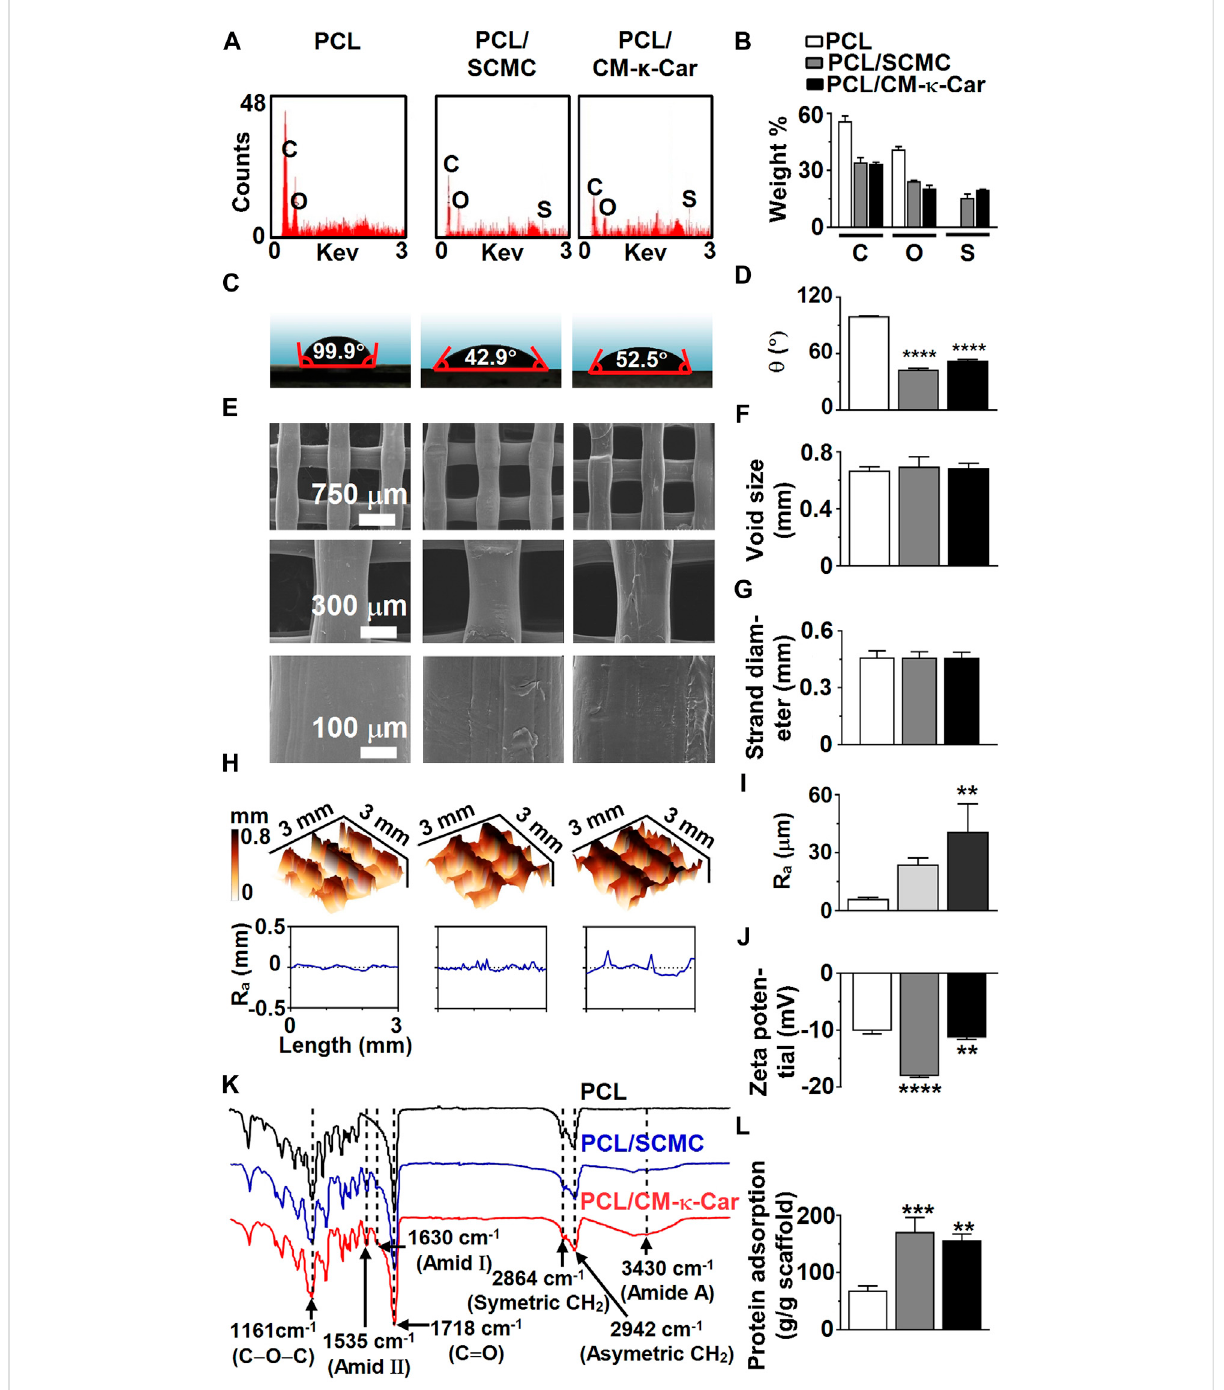
FIGURE 3 Effectofsurface-functionalizationof3D-printedPCLscaffoldsbySCMCorCM- κ -Caronsurfacechemistry,hydrophilicity,andtopography. (A) EDXspectra indicating chemical elements. (B) Weight percent of carbon, oxygen, nitrogen, and sulfate. (C) Water contact angle on surface of scaffolds. (D) Average water contactangle. (E) SEMimagesshowingthestructure,morphology,andsurfacetopographyofthestrandsinsidethescaffolds. (F) Voidsize. (G) Stranddiameter. (H) 3D-view of scaffold surface topography showing surface-functionalization-dependent variation in surface roughness distribution and magnitude. R a , average surface roughness. (I) Average surface roughness. (J) Zeta potential. (K) FTIR spectra indicating functional groups. (L) Protein adsorption on surface of scaffolds. Values are mean ± SD ( n = 3). ***Signi fi cantly different from unfunctionalized 3D-printed PCL scaffold, p < 0.0005; **** p < 0.0001. PCL, poly- ε - caprolactone; SCMC, sulfated carboxymethyl cellulose; CM- l -Car, carboxymethyl κ -carrageenan; EDX, energy dispersive X-ray spectroscopy; FTIR, Fourier- transform infrared spectroscopy, C, carbon; O, oxygen; N, nitrogen; S, sulfate. *Signi fi cantly different from unfunctionalized 3D-printed PCL scaffold, p < 0.05, **** p < 0.0001. PCL, poly- ε -caprolactone; SCMC, sulfated carboxymethyl cellulose; CM- l -Car, carboxymethyl κ -carrageenan; SEM, scanning electron